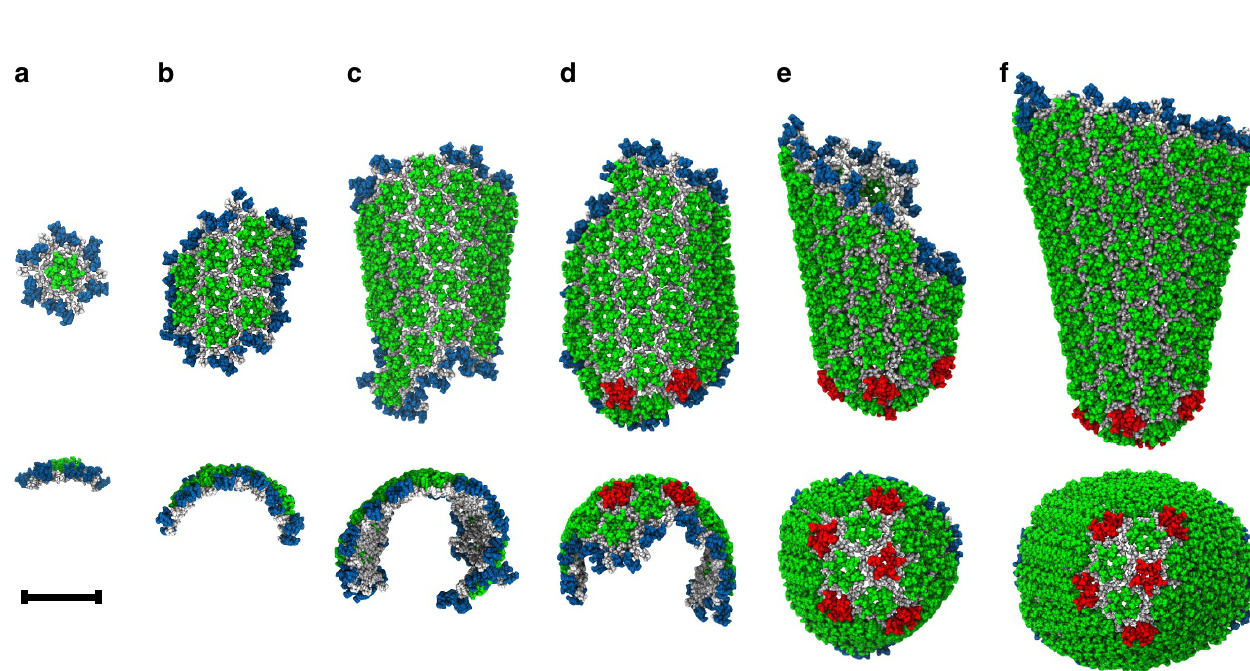
Figure 6 | Steps in the assembly of the HIV-1 capsid by polymerization of CA dimers for [CA] % ¼ 10% and conformational switching interval of 5 (cid:3) 10 5 time steps (see the main text). Simulation snapshots at 120 (cid:3) 10 6 ( a ), 240 (cid:3) 10 6 ( b ), 440 (cid:3) 10 6 ( c ), 460 (cid:3) 10 6 ( d ), 600 (cid:3) 10 6 ( e ) and 1,700 (cid:3) 10 6 MD time steps ( f ) are shown with views perpendicular and parallel to the major structural axis. Colour scheme as in Fig. 2. Scale bar,